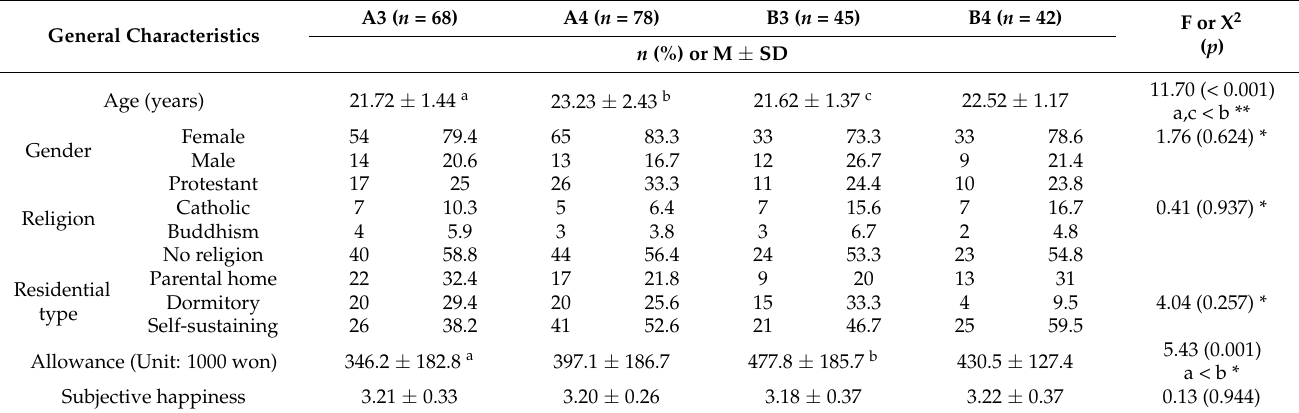
Table 1. Summary of the participants’ general characteristics and research variables.